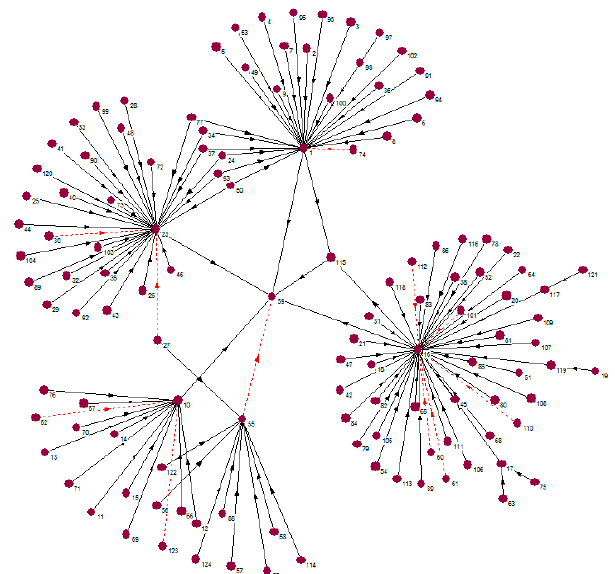
Fig. 6. [Initial] structure of the FCM